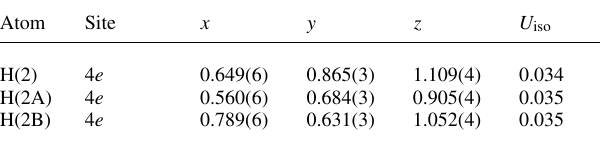
Table 2. Atomic coordinates and displacement parameters (in Å 2 )